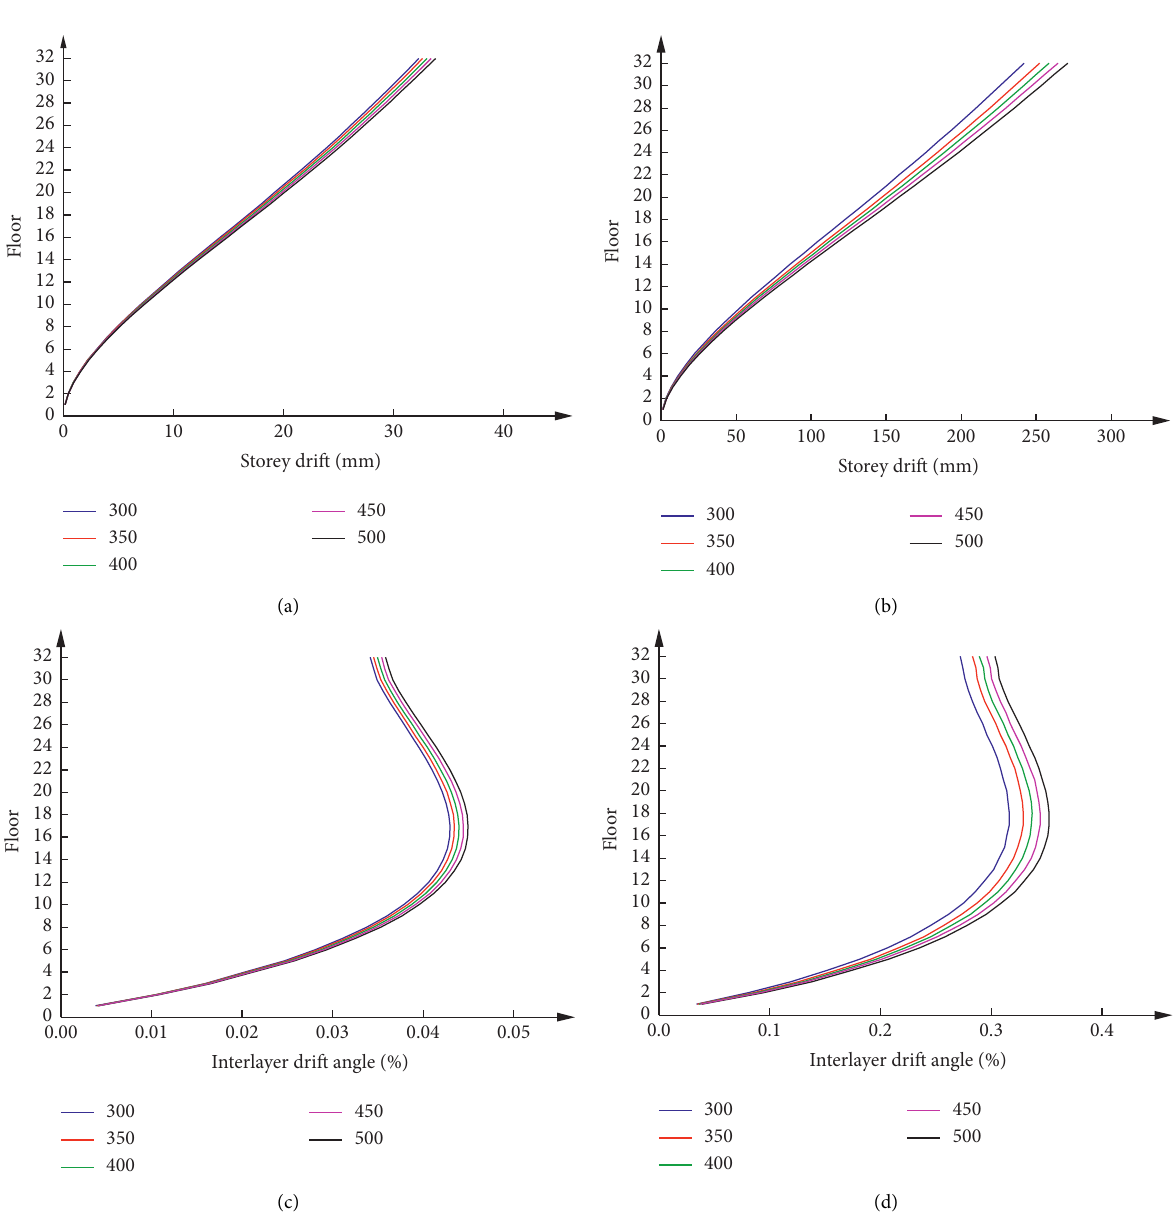
Figure 16: Effect of unbonded length on storey drift (a, b) and interlayer drift angle (c, d) in Y direction. (a) Frequent earthquake. (b) Severe earthquake. (c) Frequent earthquake. (d) Severe